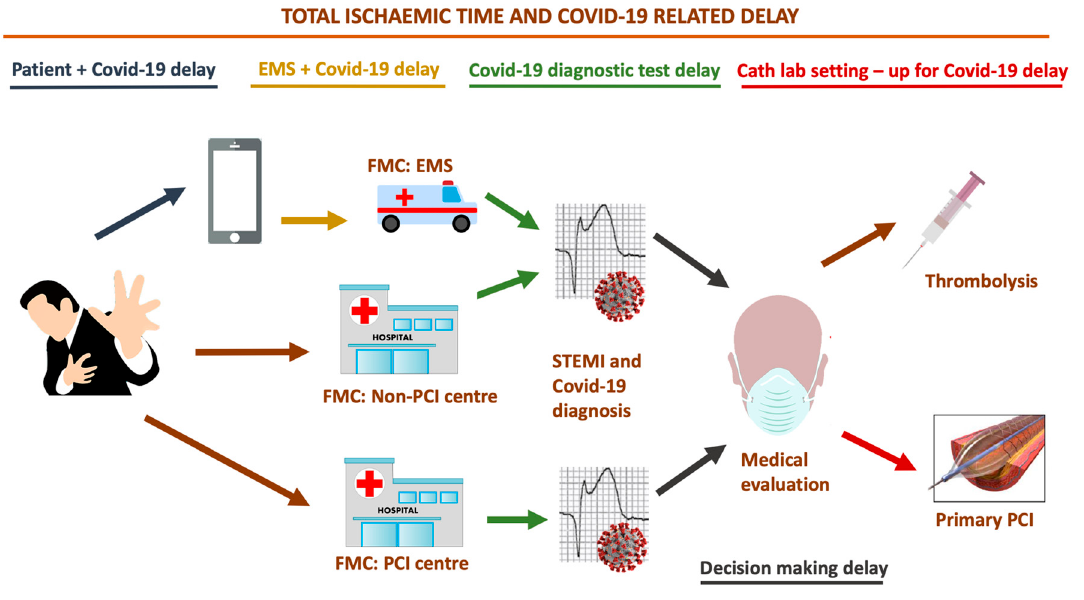
Figure 1. “Covid-19 related delays” in treating ST-elevation myocardial infarction (STEMI) patients. Adapted from Ibanez et al., 2017 European Society of Cardiology Guidelines for the management of acute myocardial infarction in patients presenting with ST-segment elevation [70]. Abbreviations: Covid-19: coronavirus disease; EMS: emergency medical services; FMC: first medical contact; PCI: percutaneous coronary intervention; STEMI: ST-elevation myocardial infarction.